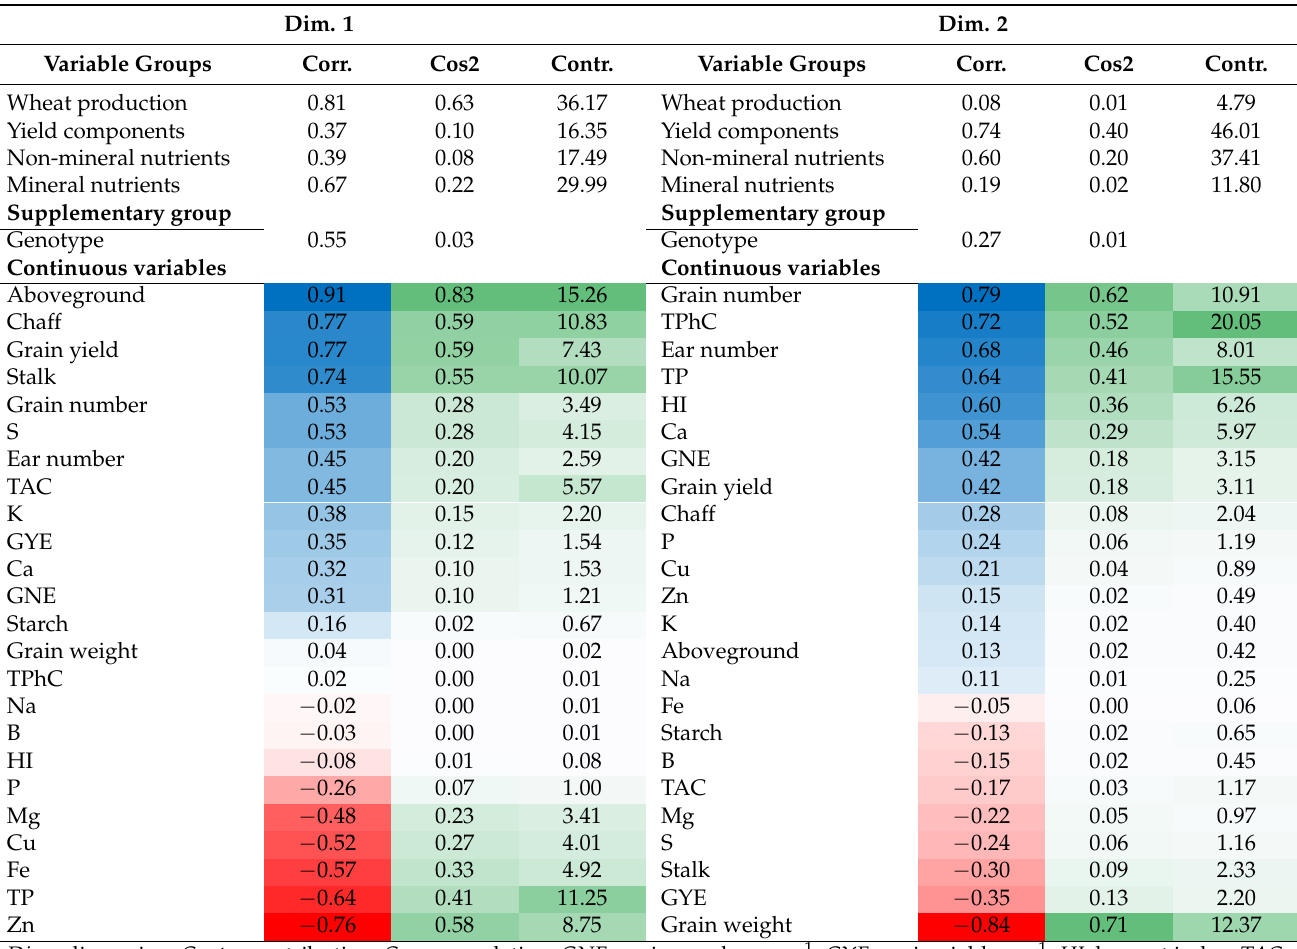
Table 5. Correlations and contributions between the original variables, the variable groups and the supplementary group with the first two dimensions of the multiple factorial analysis. Dim. 1 Dim.